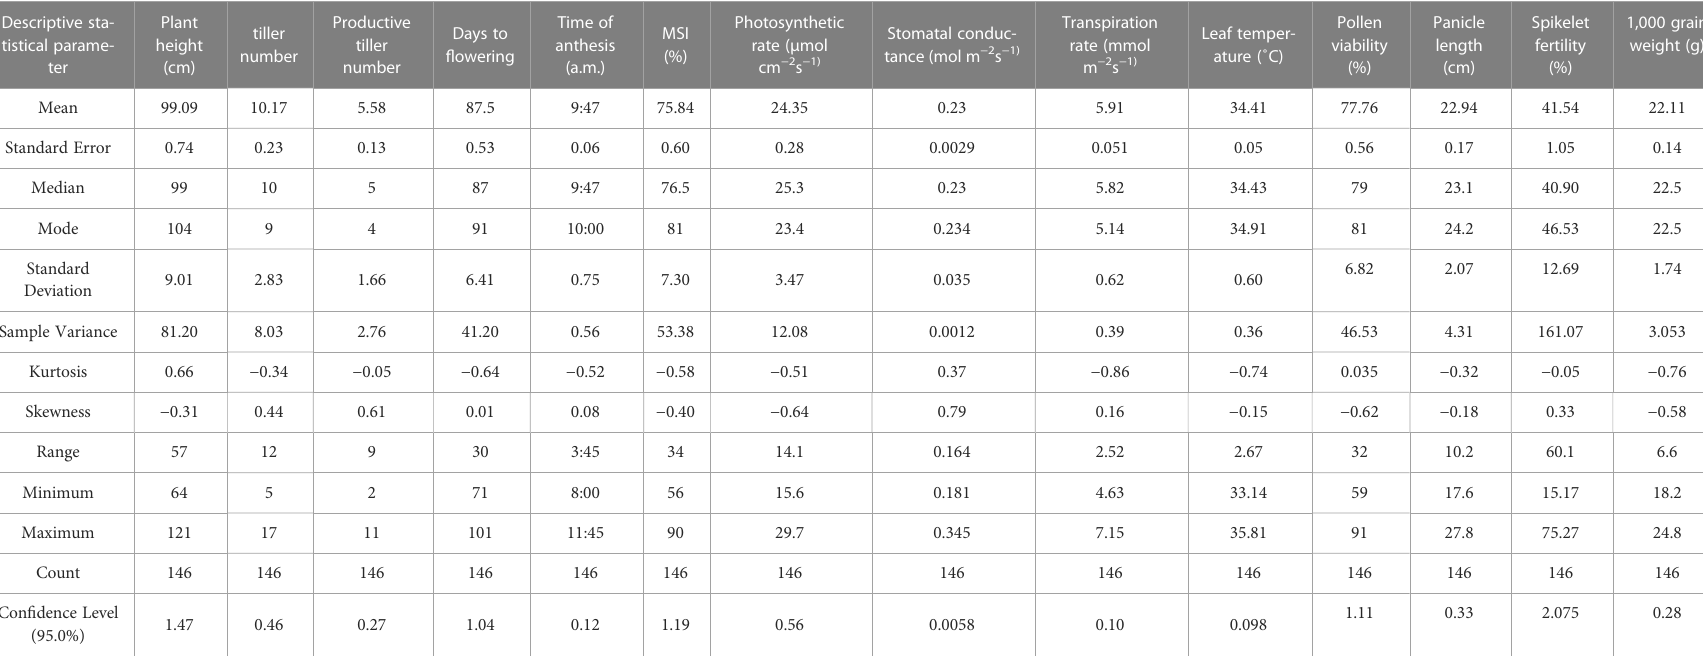
TABLE 2 Descriptive statistics of various parameters of the F 2 population of NL-44 × Uma under the effect of heat stress. Descriptive sta- tistical parame-